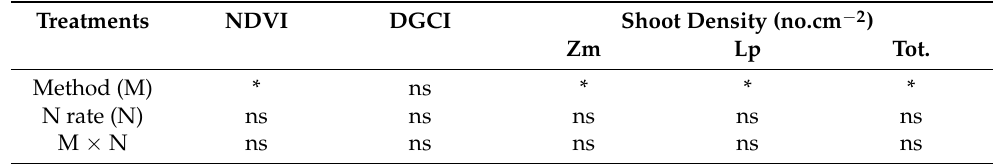
Table 2. Results of analysis of variance testing the effects of method (M) of Lolium perenne suppression (control, scalping and foaming), nitrogen application (0, 50, 100 and 200 kg N ha − 1 application rate) and their interactions on Normalized Difference Vegetation Index (NDVI), Dark Green Color Index (DGCI), and shoot density (no.cm − 2 ) of Zoysia matrella (Zm), Lolium perenne (Lp) and their mixed stand (total). NDVI, DCGI and shoot density were determined 1 June 2021, only. Treatments NDVI DGCI Shoot Density (no.cm − 2 ) Zm Lp